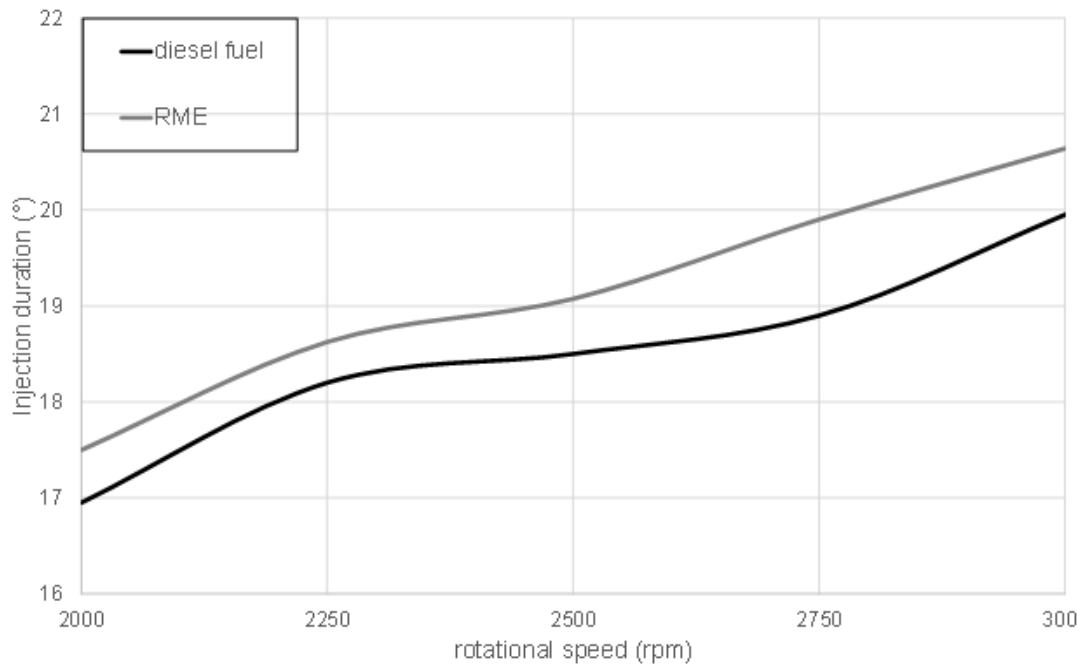
Figure 14. RME and diesel fuel injection pressures, in-cylinder pressures, and NHRR at 3000 rpm and at full load.